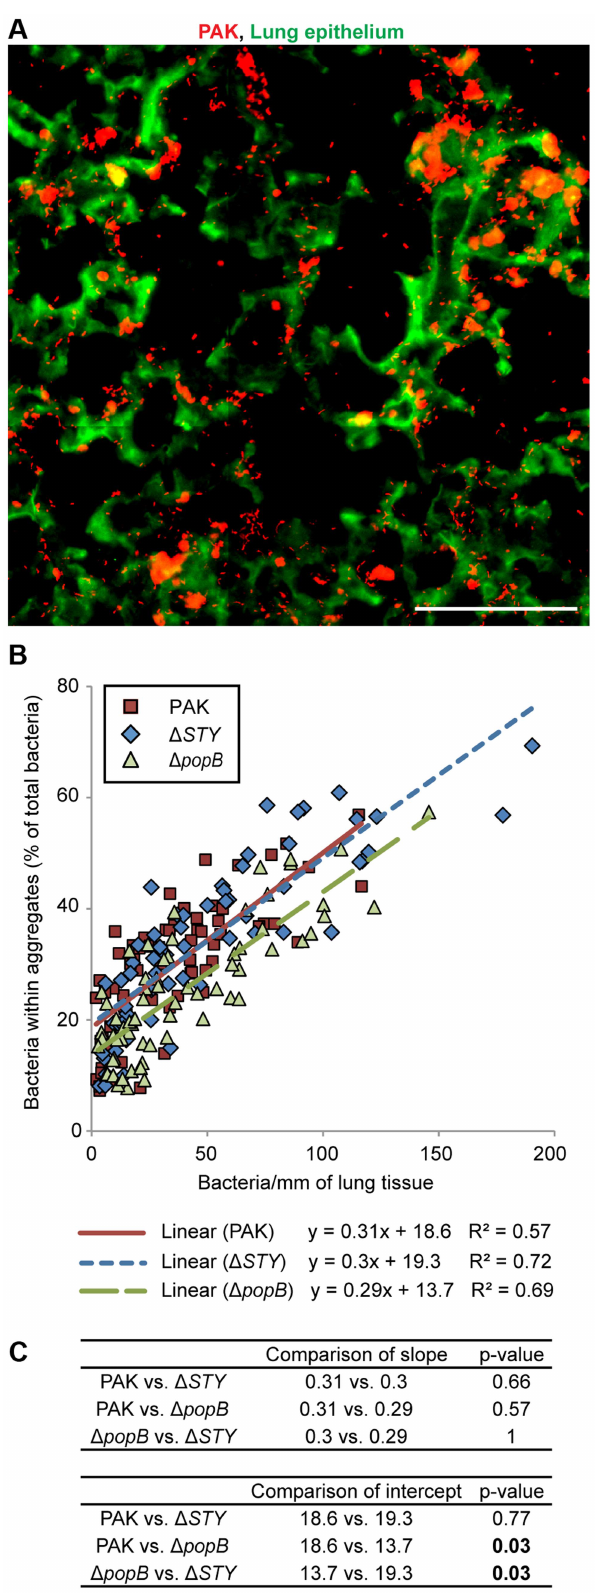
Figure 3. Bacterial aggregation in mouse pneumonia requires the T3SS translocon but does not require T3SS effectors. BALB/ c mice were injected intranasally with PAK, PAK D STY , or PAK D popB